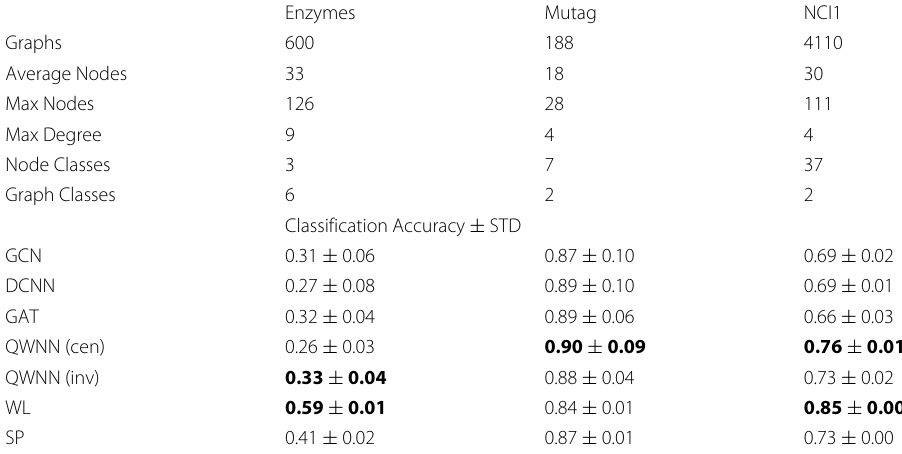
Table 2 Graph classification datasets summary and